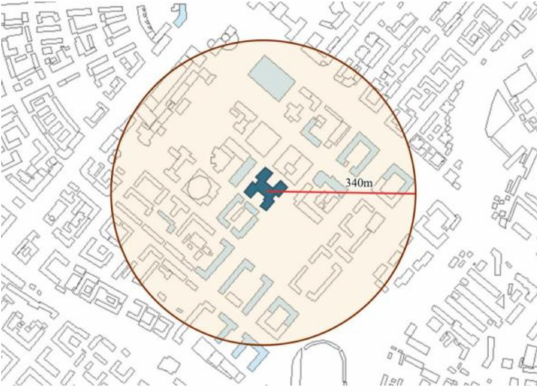
Figure 4. Neighborhood size set for building density